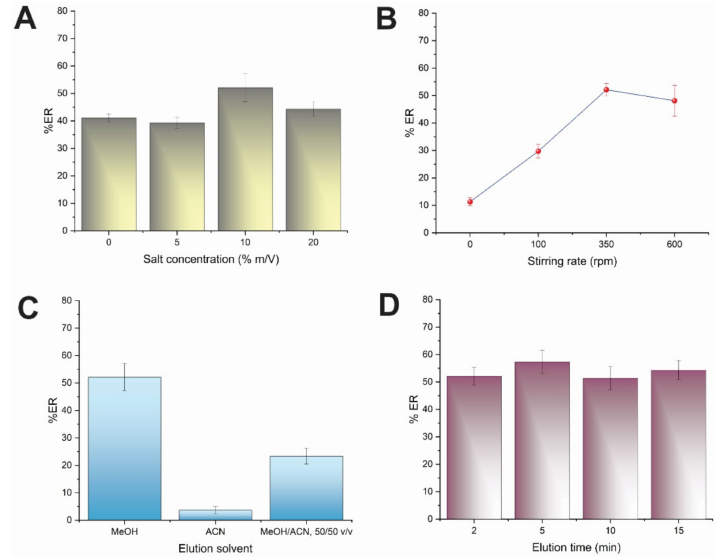
Figure 2. Effect of ( A ) salt concentration, ( B ) stirring rate, ( C ) elution solvent and ( D ) elution time on %ER of AMTB ( n =